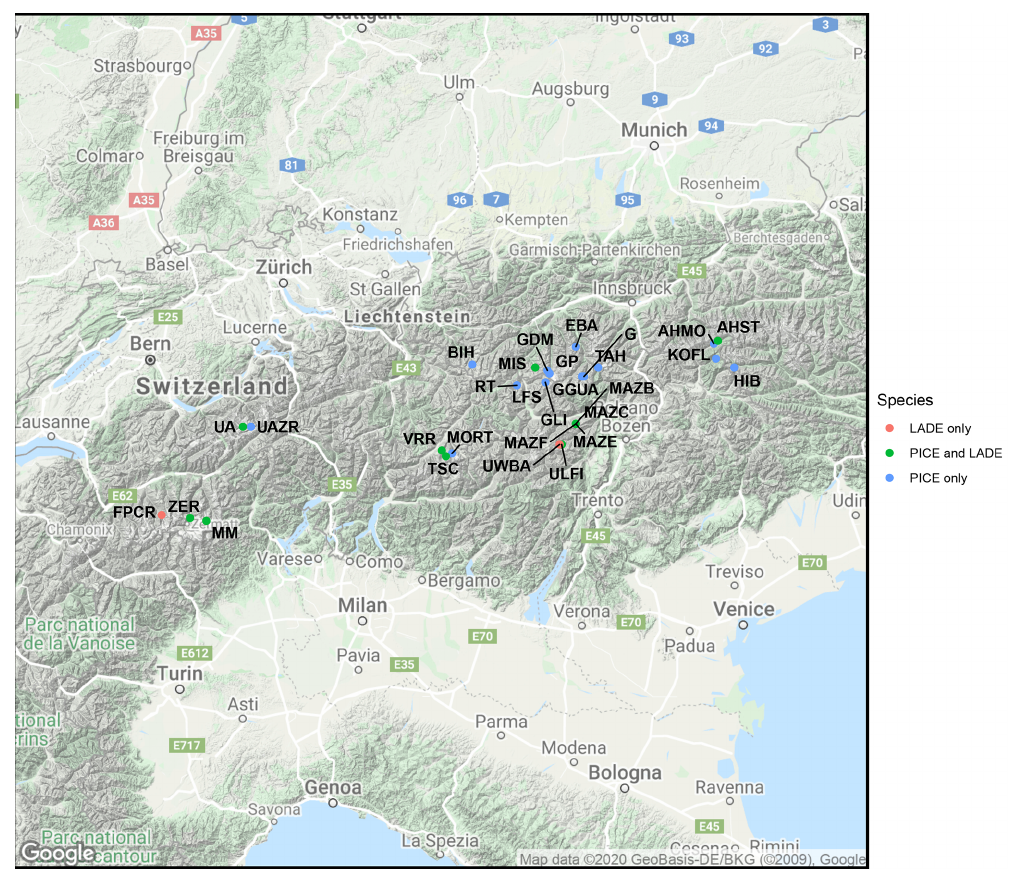
Figure 1. Map of the location of the 29 sampling sites (© Google Maps 2020): they are situated in the Swiss, the Austrian, and the Italian Alps. Information on each site is given in Table